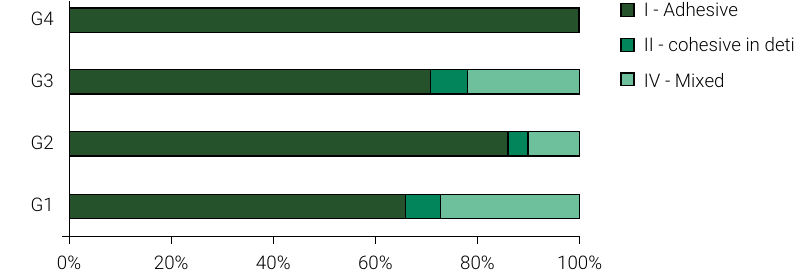
Figure 2. Percentage of failure mode for each experimental